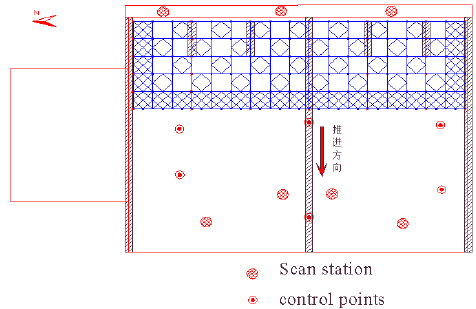
Figure 9 Scanning sites and distribution of control points